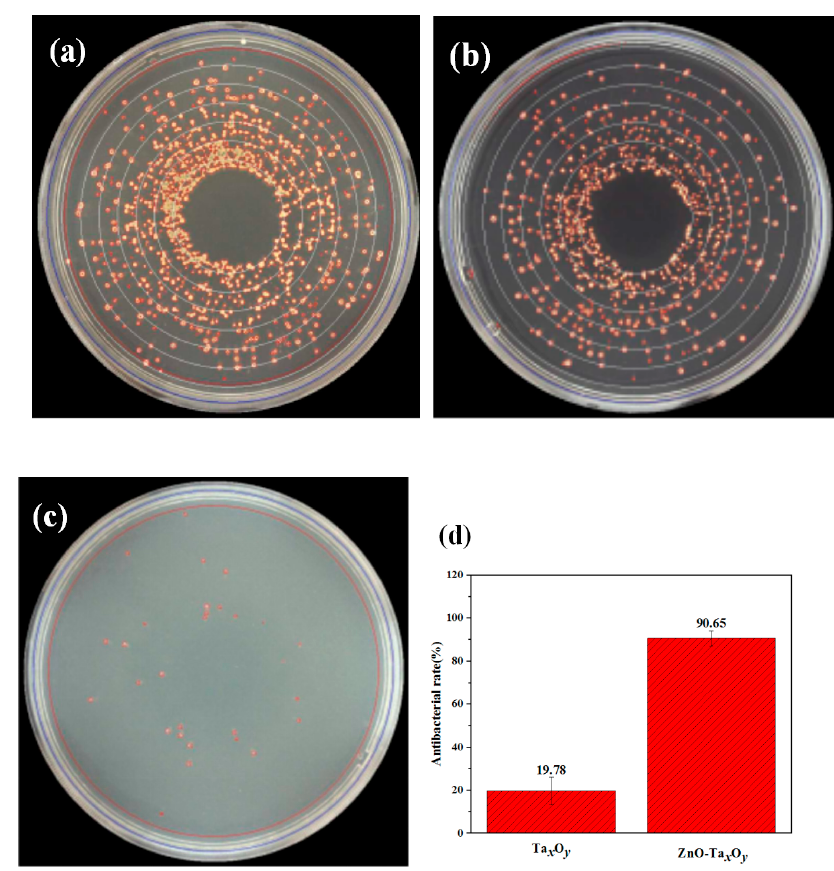
Figure 12. Images of S. aureus incubated on agar at 37 °C for 24 h on sample surface: (a) Ti6Al4V, (b) Ta x O y , and (c) ZnO-Ta x O y . Surface statistical of antibacterial rate (d).